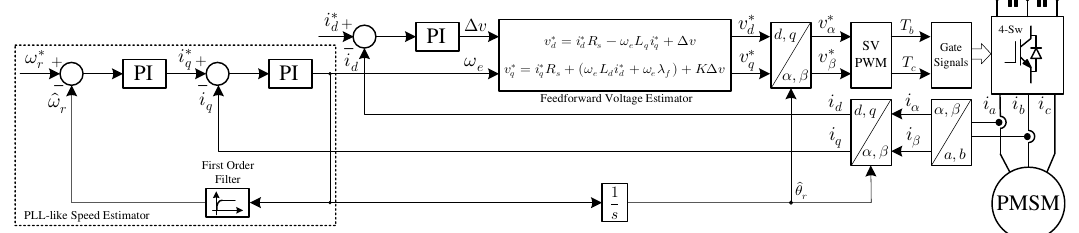
Figure 5. The proposed position sensorless PMSM drive scheme using an FSTP